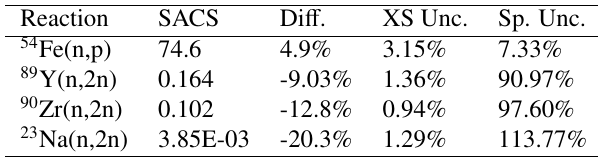
Figure 1. Overhead view inside the LR-0 reactor with a spe- cial core without moderator (left) and a dry experimental channel with activation foil holder (right).